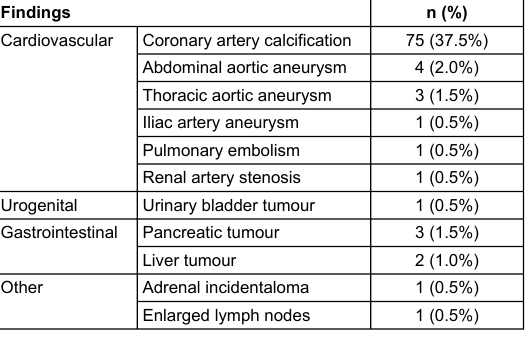
Table 2: Findings requiring immediate treatment in 85/200 patients with erectile dysfunction.